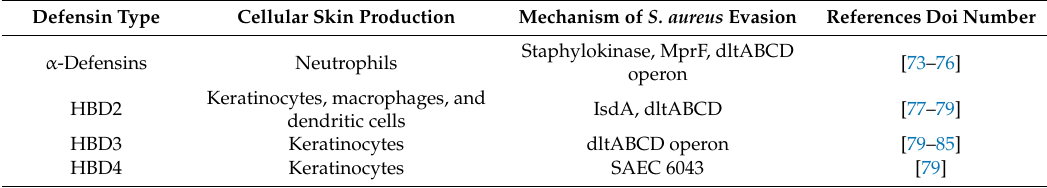
Table 1. Human defensins involved in human skin immune defenses against S. aureus